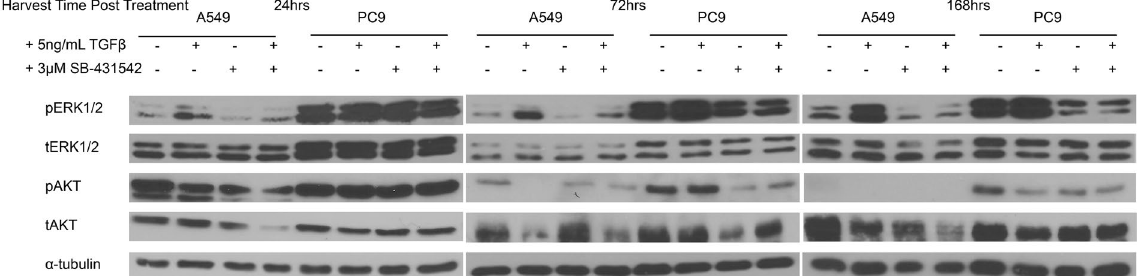
Figure 6. TGF β modulation differentially impacts ERK and AKT activation between A549 and PC9. A549 and PC9 cells were plated, treated, and harvested as described in the methods. α -tubulin levels are representative of an individual lysate pool. Lysates profiled here are the same as in Fig. 2. ERK-MAPK and PI3K-AKT signaling are non-canonical signaling effectors of the TGF β signaling